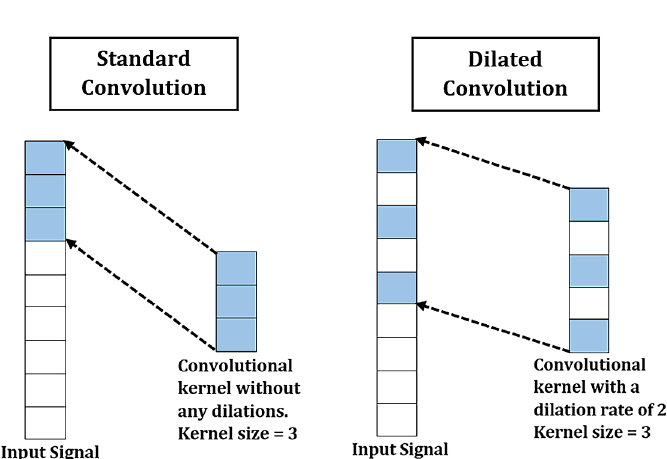
Figure 5. Comparison between standard and dilated convolution.